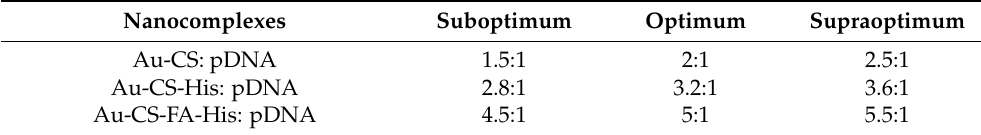
Table 1. Suboptimum, optimum and supraoptimum FAuNP:pDNA ( w / w) ratios that were obtained from the band shift